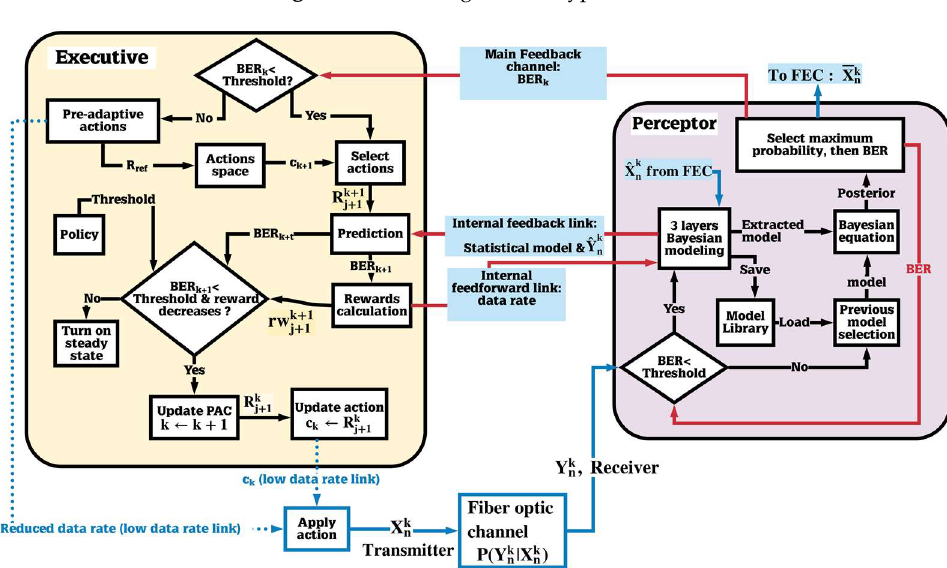
Figure 7. The proposed CDS for the long-haul fiber optic link.